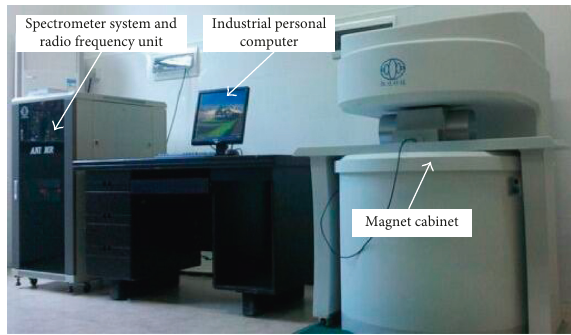
Figure 1: AniMR-150 NMR imaging